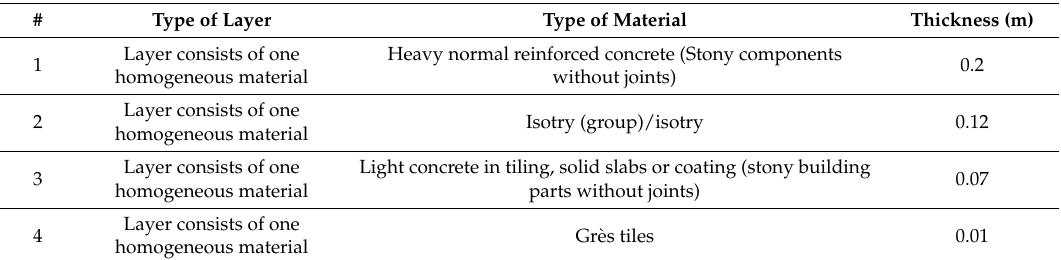
Table 12. Extracted data of composition of floor out of the